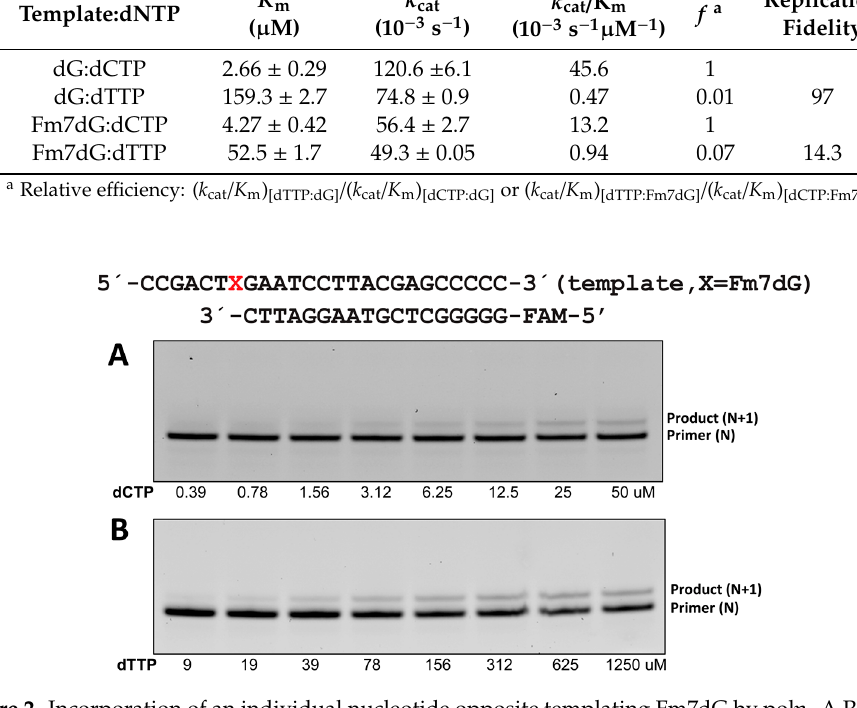
Figure 2. Incorporation of an individual nucleotide opposite templating Fm7dG by pol η . A PAGE-urea gel for insertion of dCTP ( A ) or dTTP ( B ) opposite Fm7dG by pol η . Pol η , Fm7dG-containing 25 mer template, 18 mer primer, and incoming nucleotides were used for the reaction.